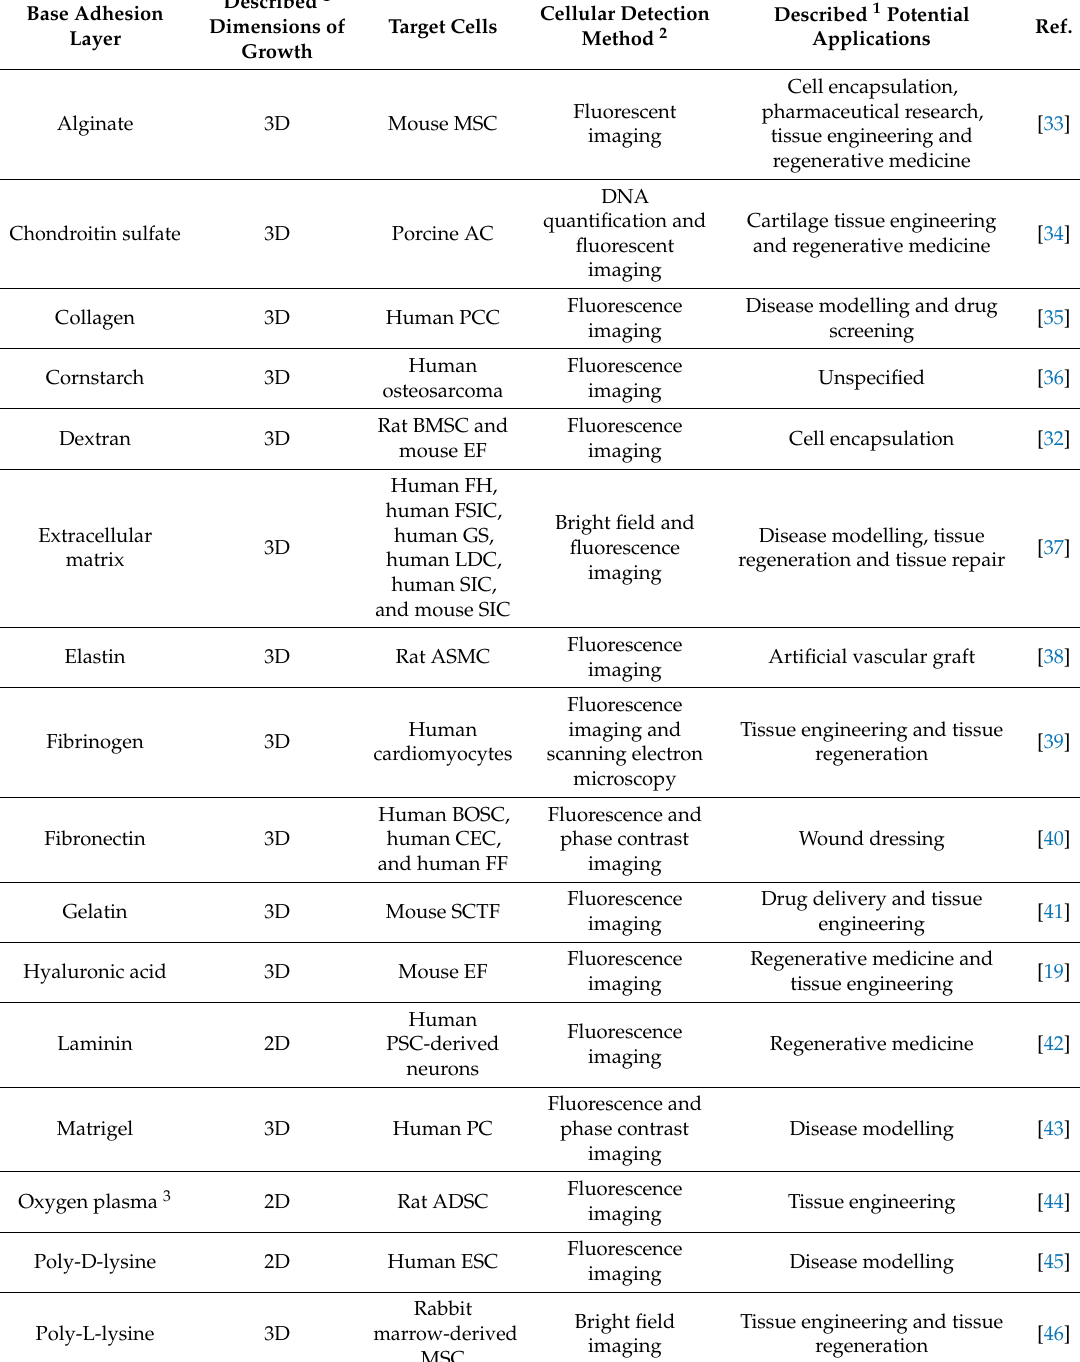
Table 1. Examples of non-specific cell type biointerfaces that promote